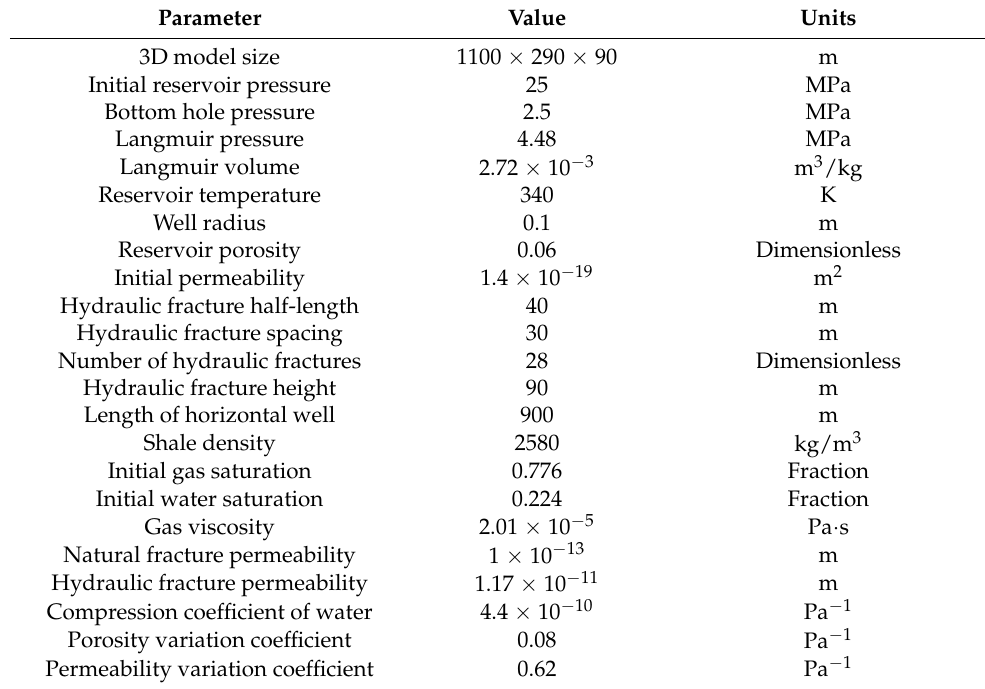
Table 1. Parameters related to the Barnett Shale gas reservoir.